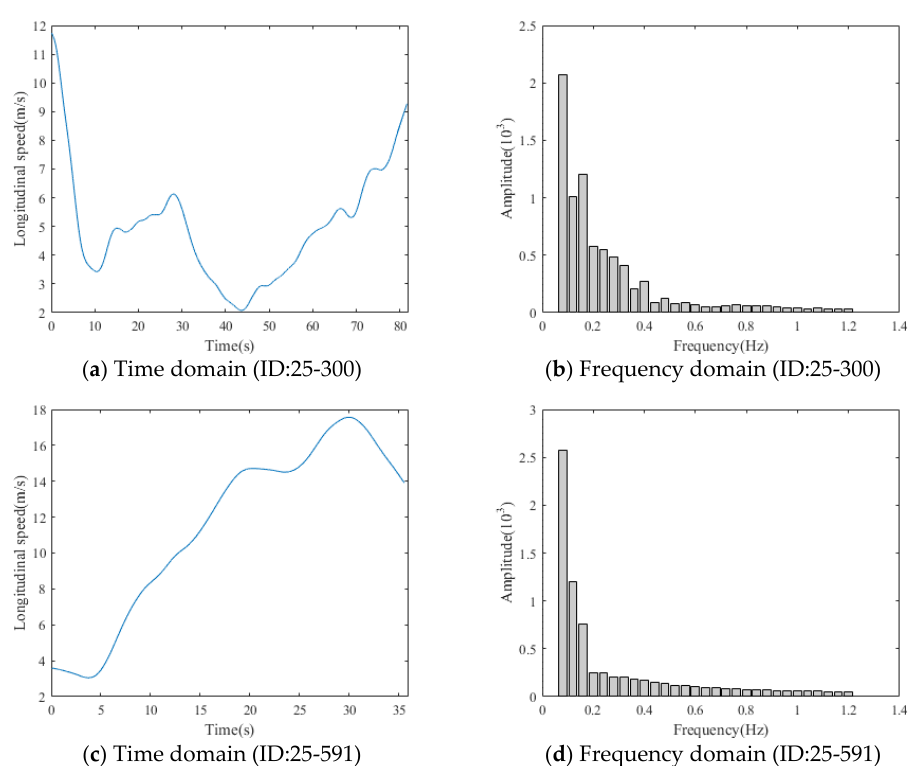
Figure 3. Rear-end collision evaluation for the target vehicle.